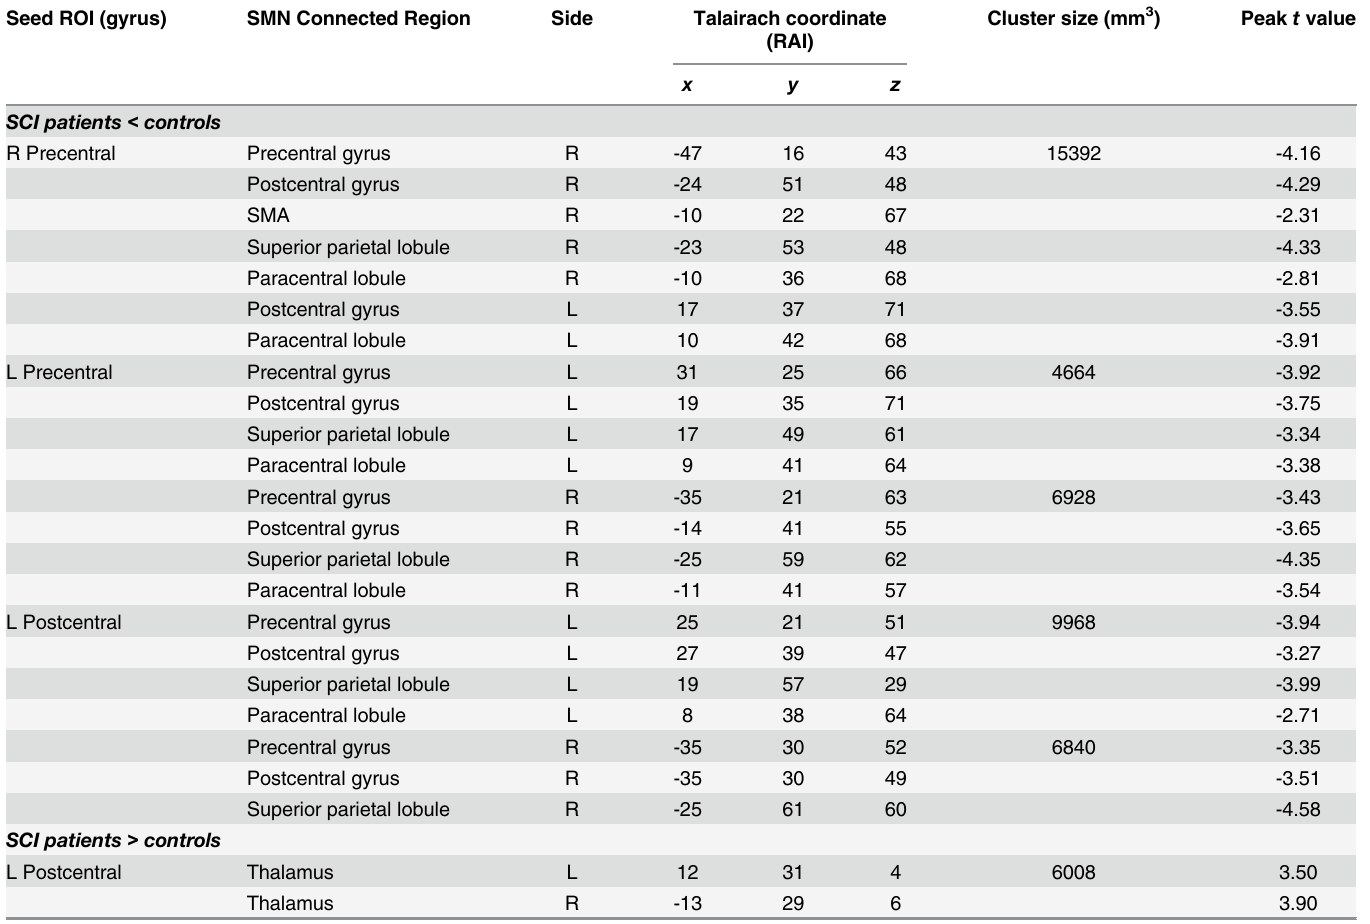
Table 3. Brain regions showing significantly altered functional connectivity in SCI patients. Seed ROI